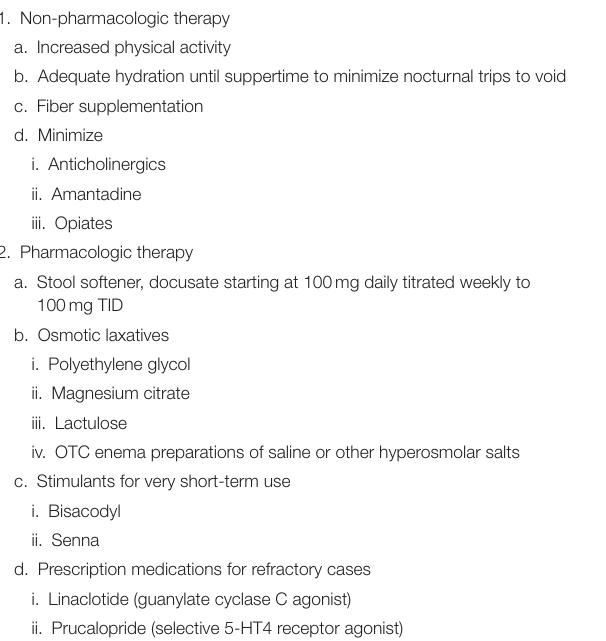
TABLE 5 | Management of constipation in